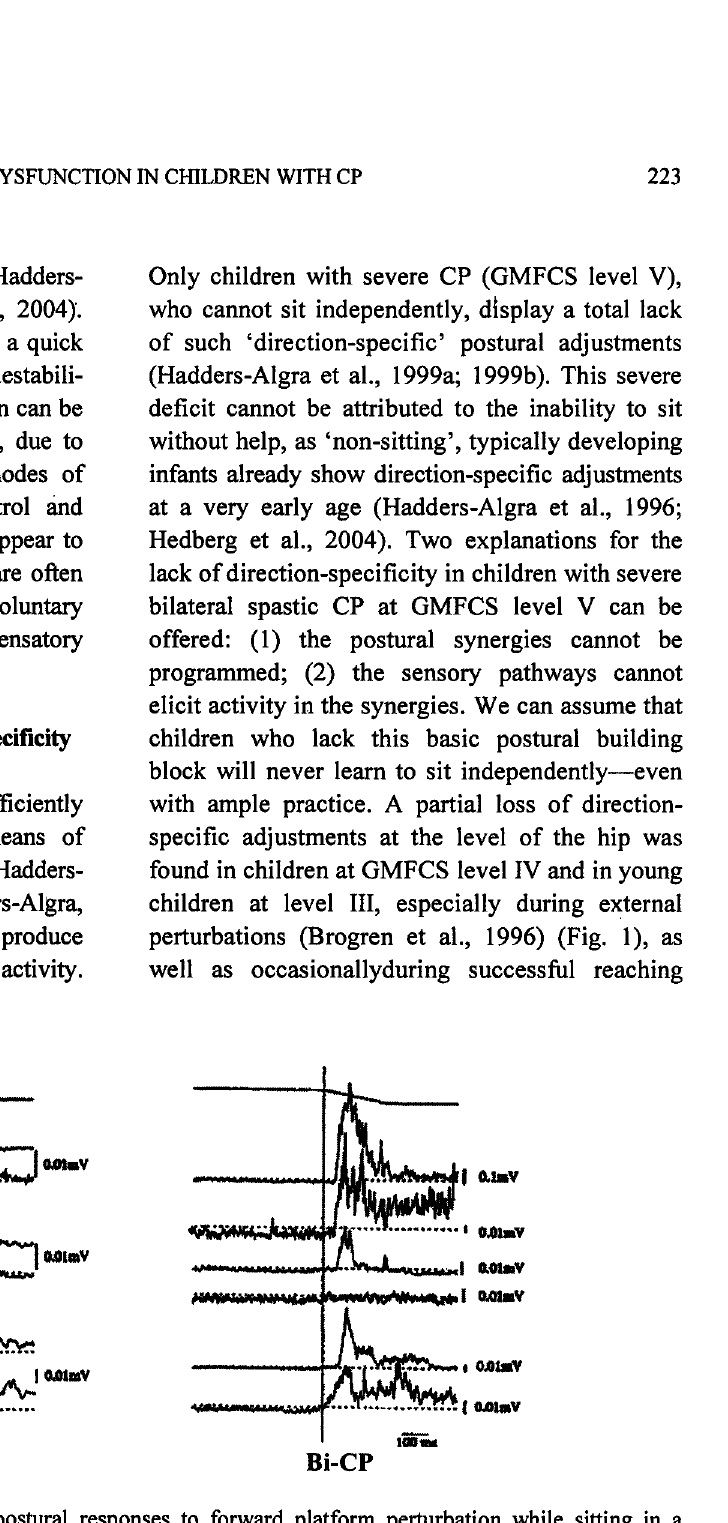
Fig. 1: Mean averaged EMG recordings of postural responses to forward platform perturbation while sitting in a typically developing child (TD) and a child with bilateral spastic CP (Bi-CP), GMFCS- level IV. TD child shows appropriate direction specific activity in the ventral neck-, triank-, and leg muscle; Bi-CP child" a partial lack of direction-specific adjustment: activity in HAM precedes activity in RF. Plf=platform signal; NF=neck flexor; NE=neck extensor; RA=rectus abdominis; LE; lumbar extensor; RF=rectus femoris; HAM=Hamstrings. Dotted lines indicate baseline muscular activity + 2 SD; vertical line denotes perturbation onset. (Adapted from Brogren et al.,